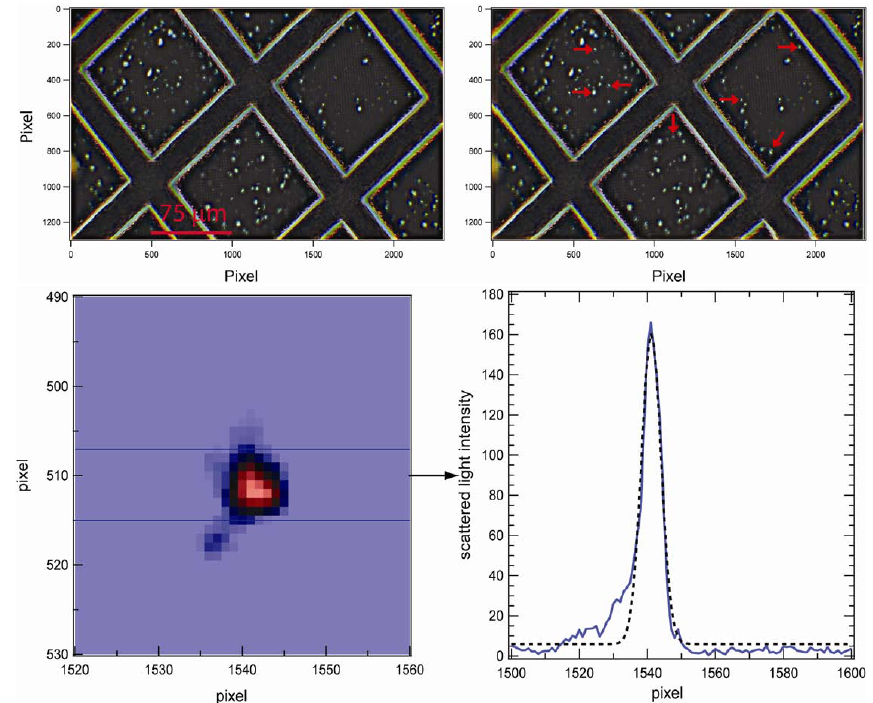
Fig. 4. Two sequential frames obtained at 60 frames/second using the 20X objective: the first frame (top left) and the consecutive frame Figure 4 (top right). The optical image size is 345.6µm by 194.4µm. 200nm particles were used. New particles arrived between the two frames are identified with a red arrow in the consecutive frame. Bottom left panel depicts a portion of the difference photo showing a single particle. The profile of this particle is defined by two blue lines. Its scattered light intensity is depicted in the bottom right panel. A Gaussian fit (shown in the dashed line) is used to determine the peak height, width, center, and